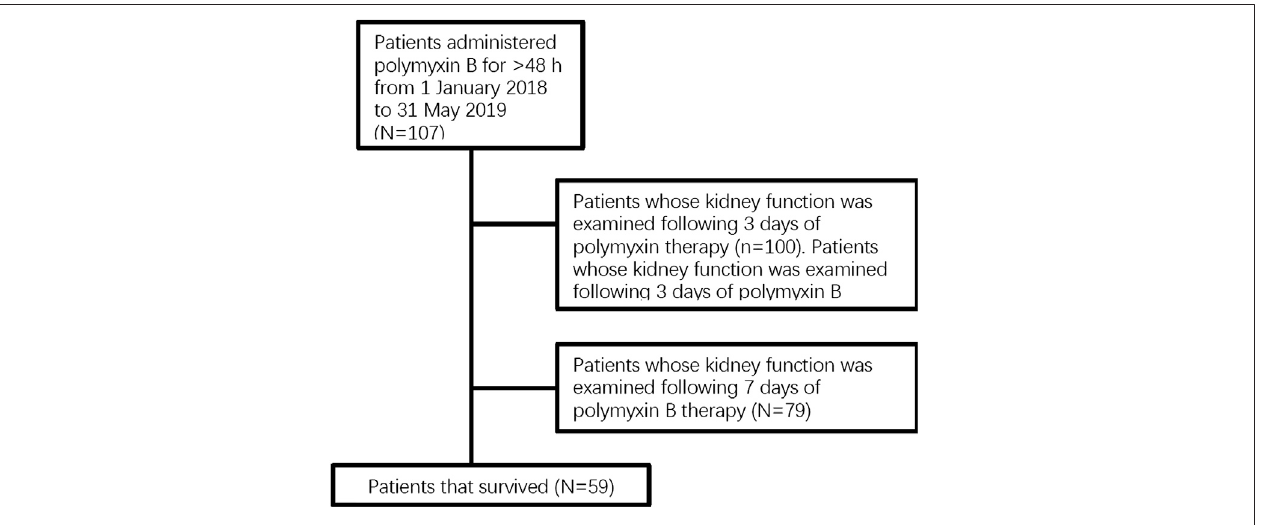
FIGURE 1 | Flow chart of the number of eligible